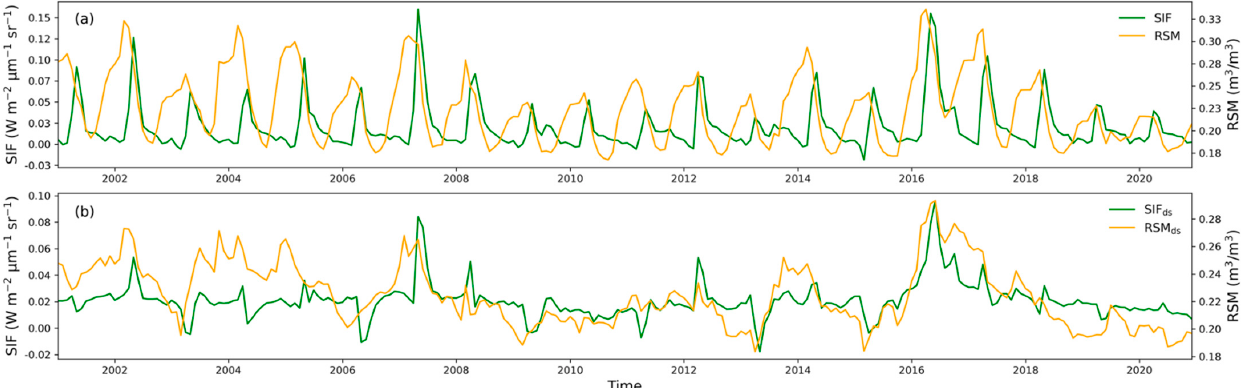
Figure 3. Comparison between the original time series of SIF and RSM at 50°N and 70°E and the deseasonalized time series of them. ( a ) represented the original time series of SIF and RSM, and ( b ) showed the deseasonalized time series of SIF (SIF ds ) and RSM (RSM ds ).